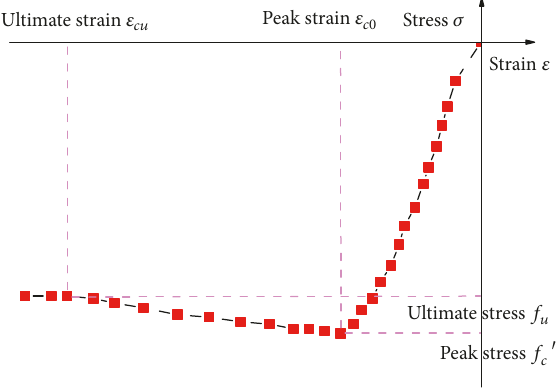
Figure 1: General arrangement diagram for bridge.